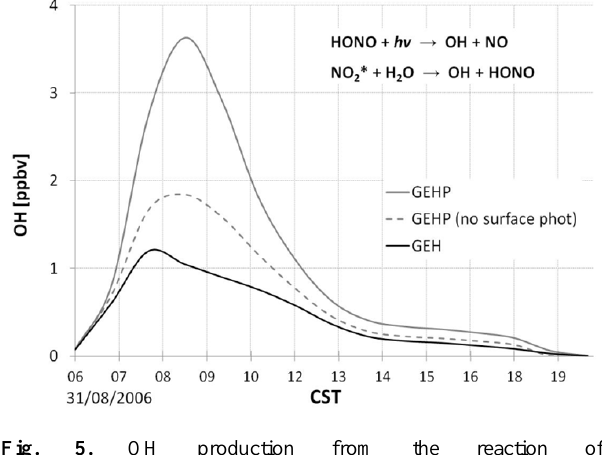
Fig. 5. OH production from the reaction of HONO+ hν → OH+NO and NO 2 ∗ +H 2 O → OH+HONO.